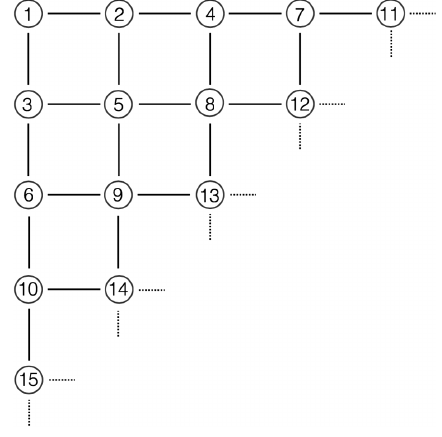
FIG. 1. Total order of the measurements for a generic n × m cluster state used as a resource state in Protocol